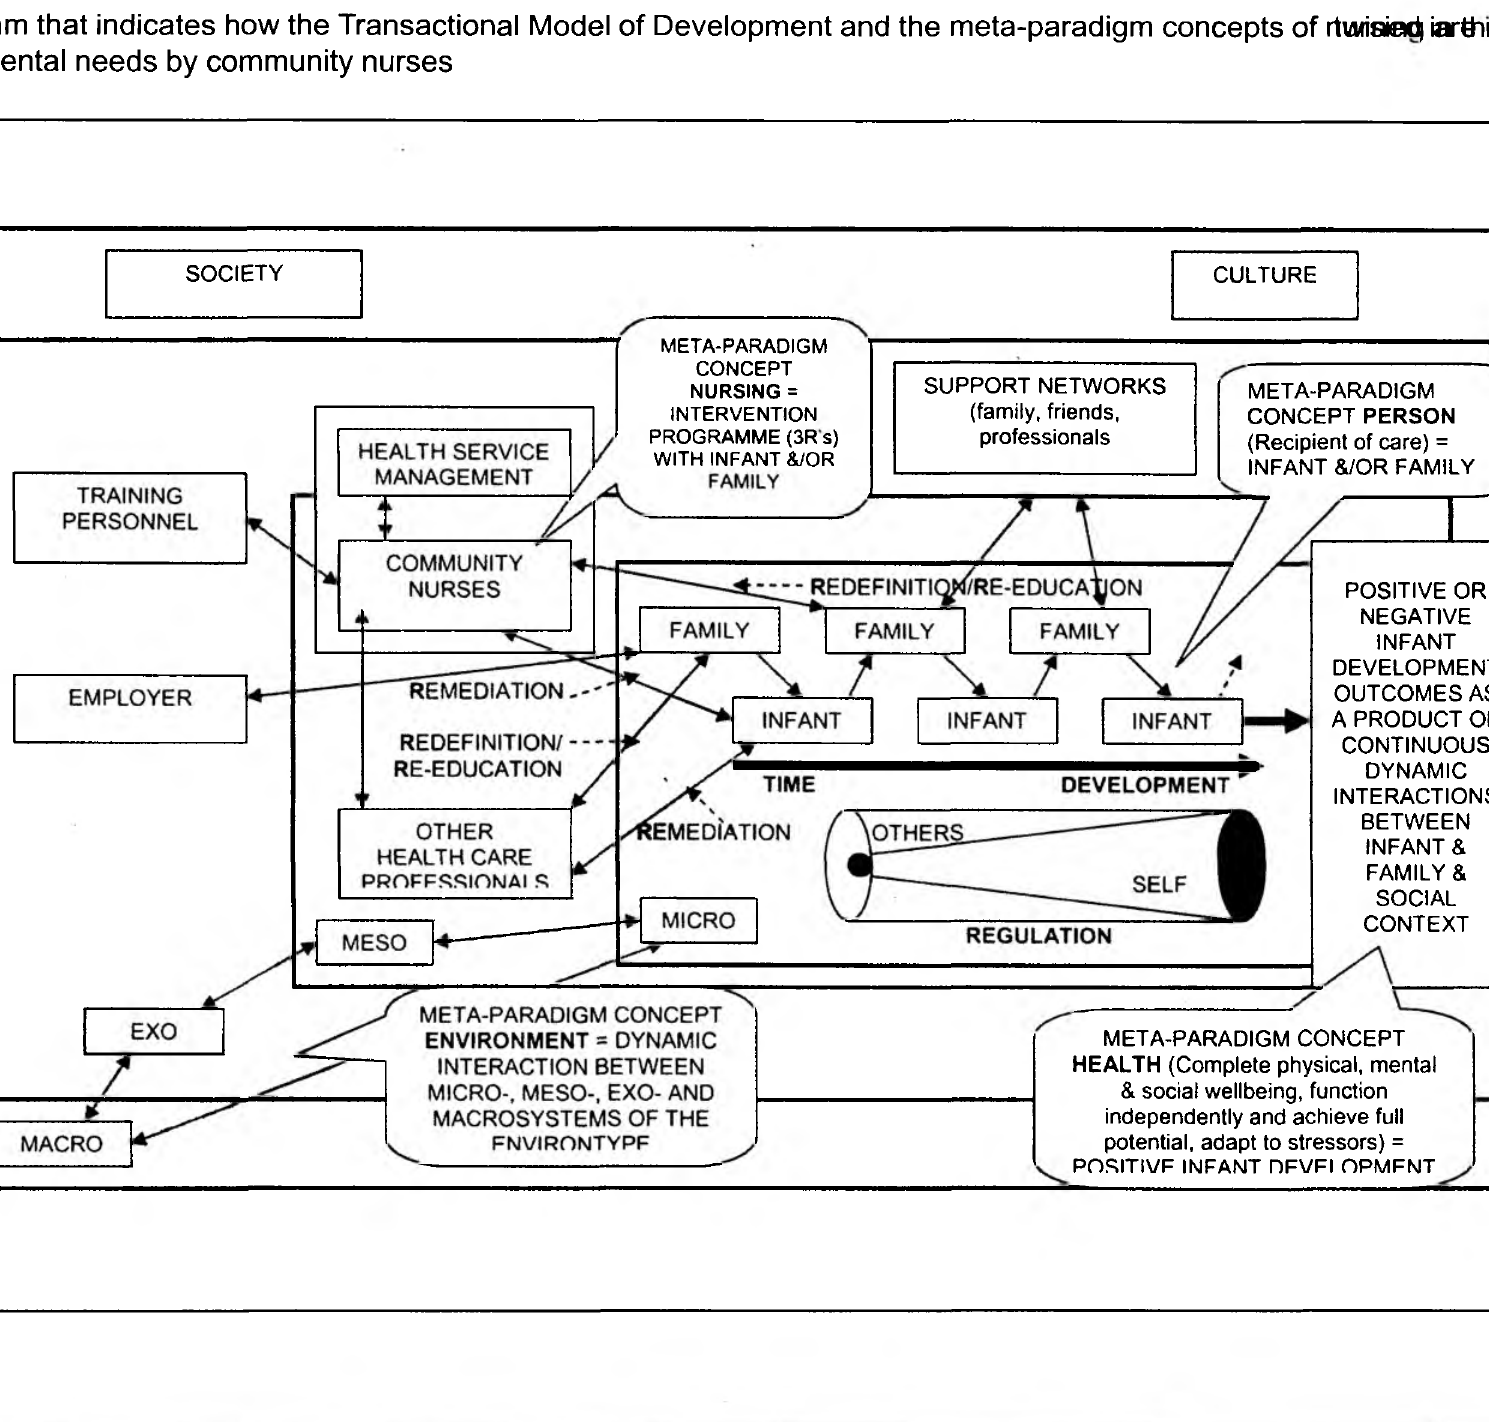
Figure 1: Diagram that indicates how the Transactional Model of Development and the meta-paradigm concepts of rtvuiaiedi iarëiBitBBnagement of infant developmental needs by community nurses